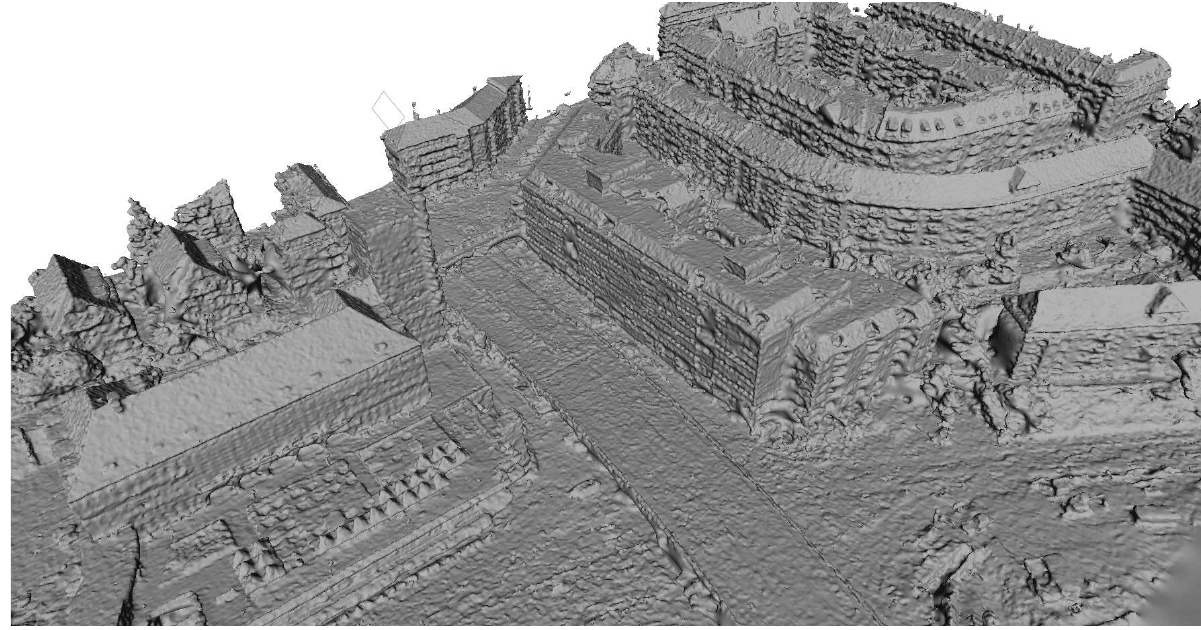
Figure 8: Poisson reconstruction based on our point sets. RQT error threshold ǫ = 2 .